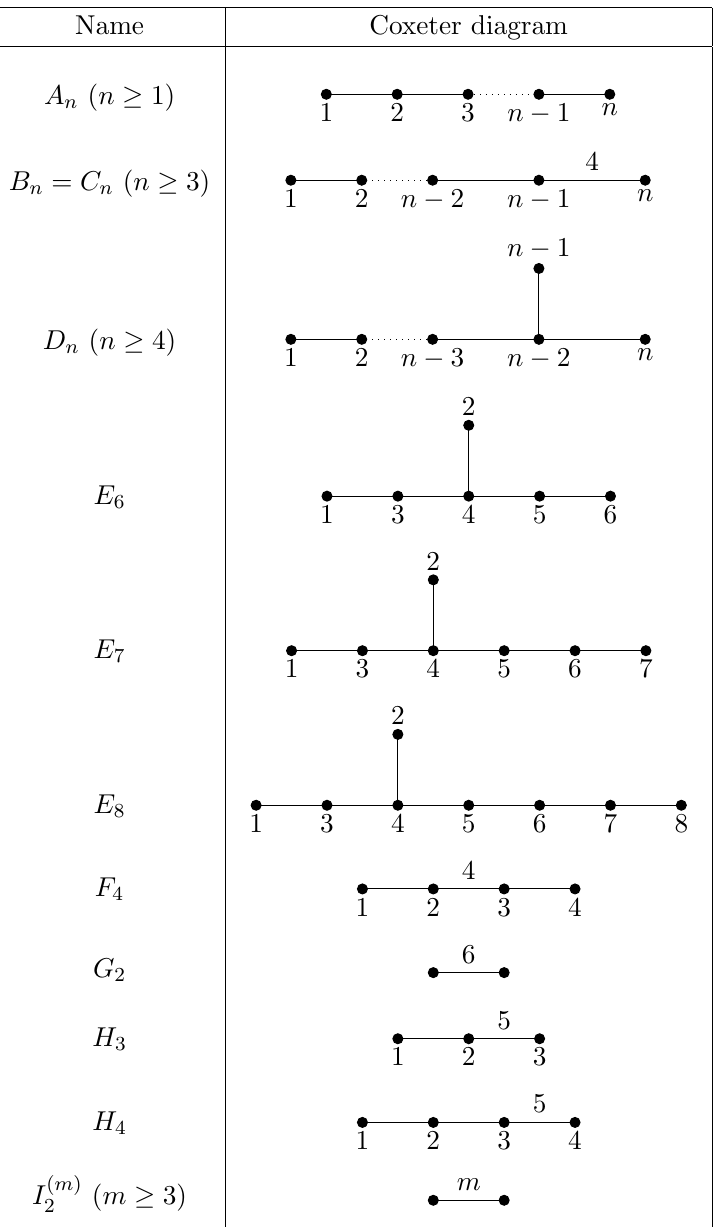
Table 1 . Diagrams of irreducible (cid:12)nite Coxeter systems. Table reproduced from